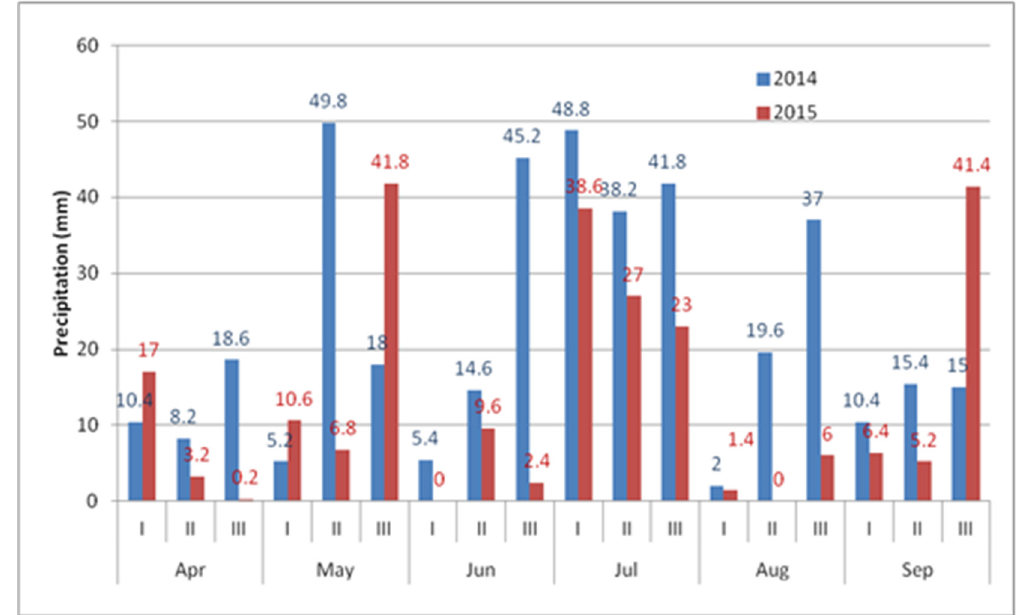
Figure 1. Rainfall distribution (mm) during the growing period of April–September in the two years of the experiment, divided into 10-day periods.